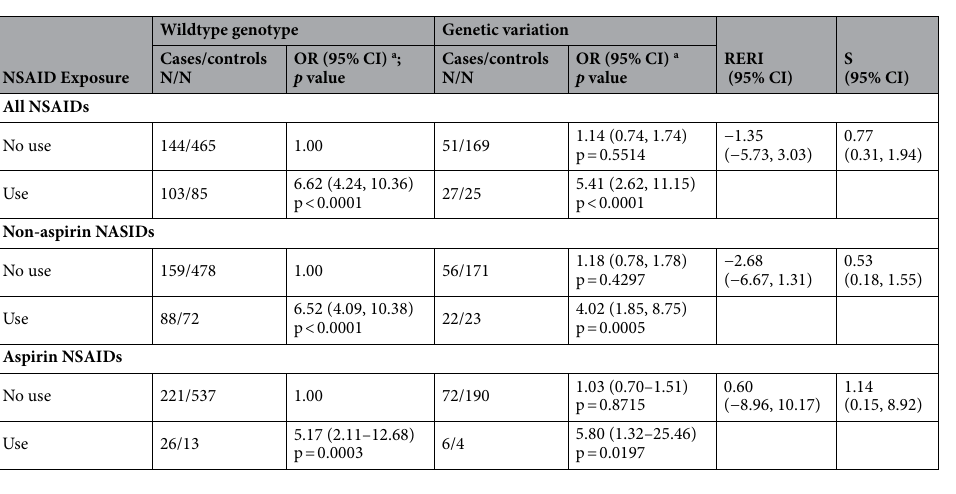
Table 3. Effect of e-NOS intron 4 VNTR polymorphism and NSAIDs exposure on the risk of UGIH. CI, confidence interval; N, number of participants; OR odds ratio; RERI, Relative Excess Risk due to Interaction; S, Synergism Index. a Odds Ratio adjusted for: period of patients’ recruitment, previous history of arthrosis, infection with Helicobacter pylori , gastrointestinal disorders (ulcer and bleeding), exposure to inhibitors of the proton pump, exposure to antiaggregant, exposure to anticoagulants, the number of conducted interviews, and the reliability of the interview. Aspirin subgroup analysis was additionally adjusted for exposure to non-aspirin NSAIDs. RERI = 0 and S = 1 imply no interaction, RERI > 0 and S > 1 imply positive interaction and RERI < 0 and S < 1 imply negative